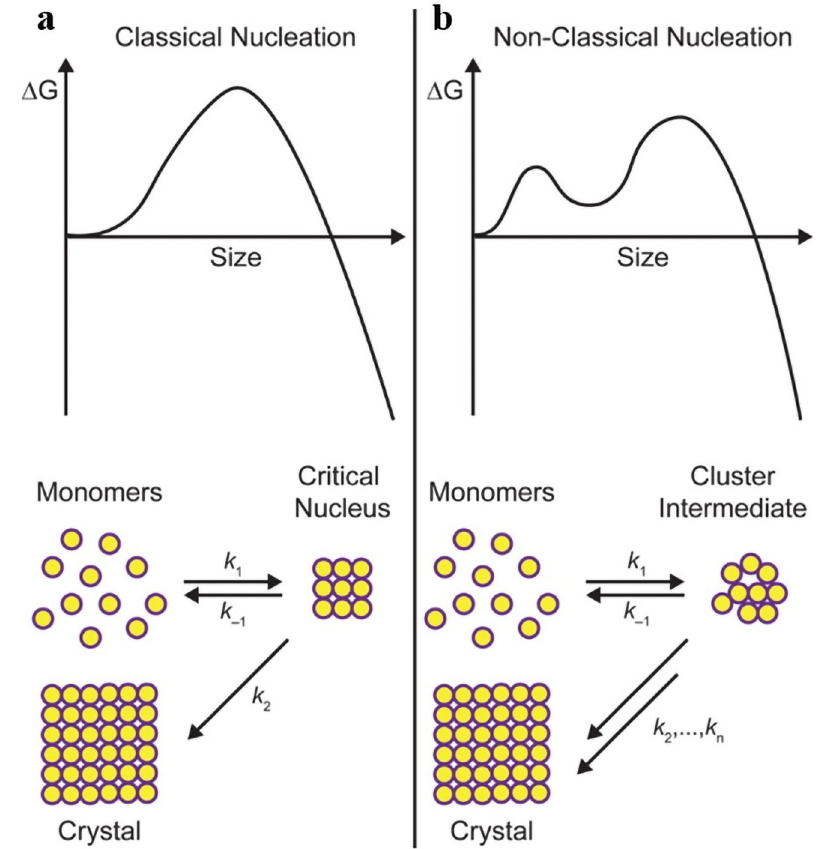
Figure 3. Schematic diagram of free energy as a function of particle size and crystallization for ( a ) classical and ( b ) non-classical nucleation models. Reprinted with permission from Ref. [58]. © 2016, American Chemical Society.